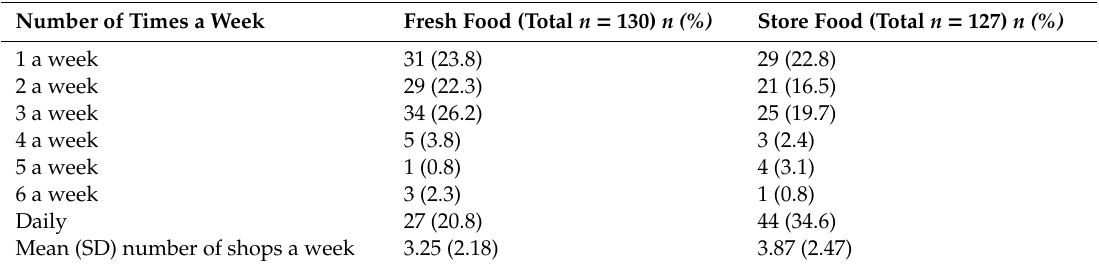
Table 4. Number of shopping experiences per week for fresh and store